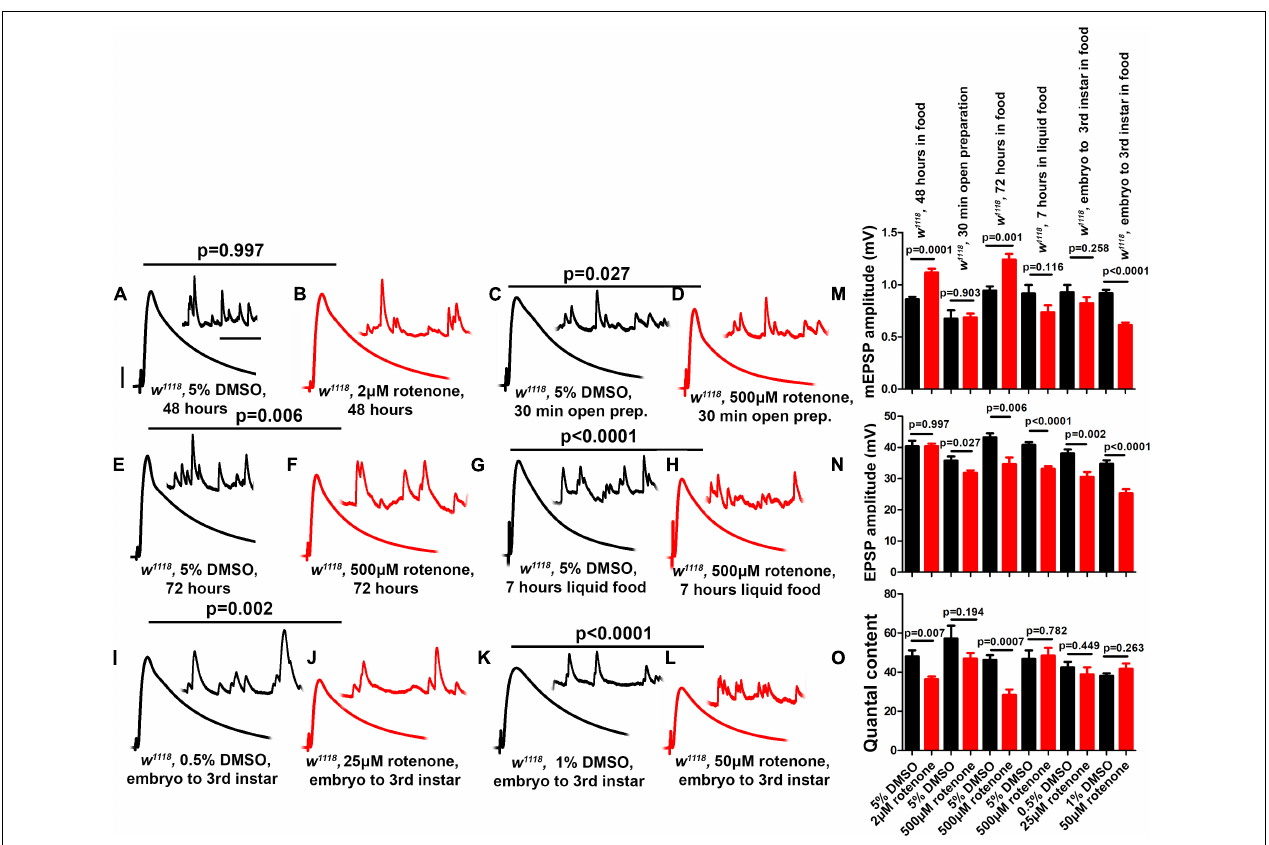
FIGURE 5 | Rotenone diminishes neurotransmission at the NMJ. (A–L) Representative traces for third instar wild-type larvae treated or fed with DMSO and rotenone at various concentrations as indicated above. Scale bars for EPSPs (mEPSPs) are x = 50 ms (1000 ms) and y = 10 mV (1 mV). (M–O) Histogram showing average mEPSP, EPSPs amplitude and quantal content of larvae treated with DMSO and rotenone in the indicated conditions. Note that larvae treated or fed a high dose of rotenone showed decreased EPSP amplitudes compared to carrier controls. The flies were grown in a molasses media and recordings were performed at 25 ◦ C. At least 8 NMJs recordings of each genotype were used for quantification. p -values for EPSPs are indicated in Supplementary Table 4 . Statistical analysis based on Student’s t -test for pairwise comparison. Error bars represent mean ±